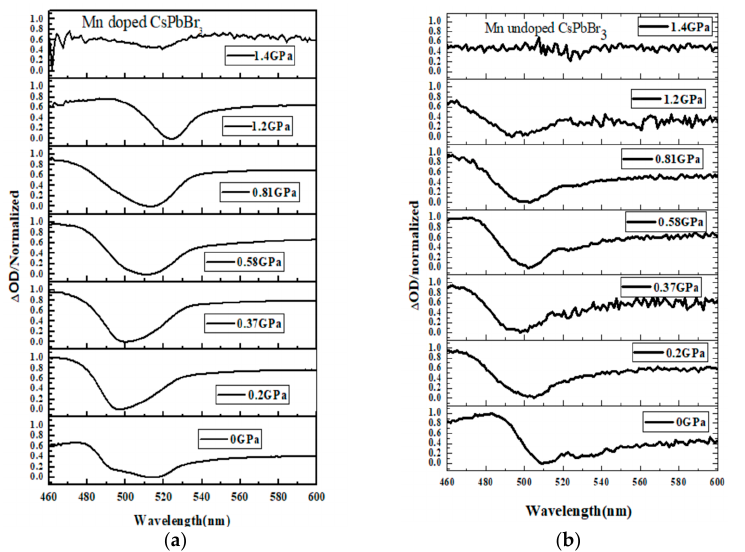
Figure 5. ( a , b ). Transient absorption spectra of Mn-doped and undoped CsPbBr 3 under different Figure 5. ( a , b ) Transient absorption spectra of Mn-doped and undoped CsPbBr 3 under different pressures.